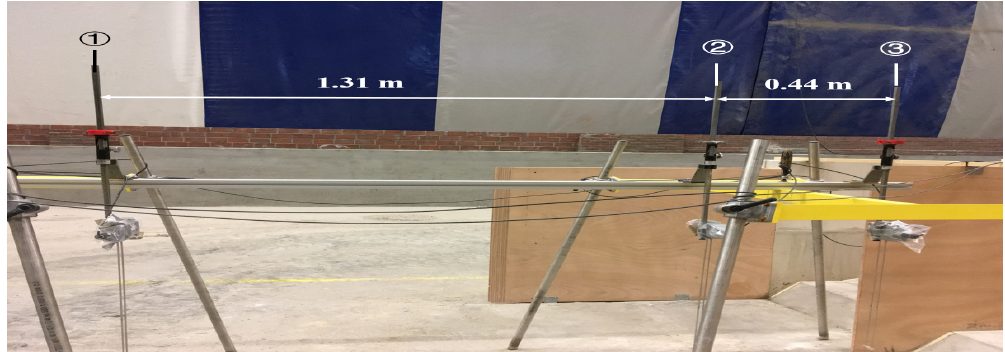
Figure 4. Experimental instruments for measurement with ( a ) wave gauges in front of models (side view) and ( b ) overtopping chute and overtopping tank with wave gauge (top view).